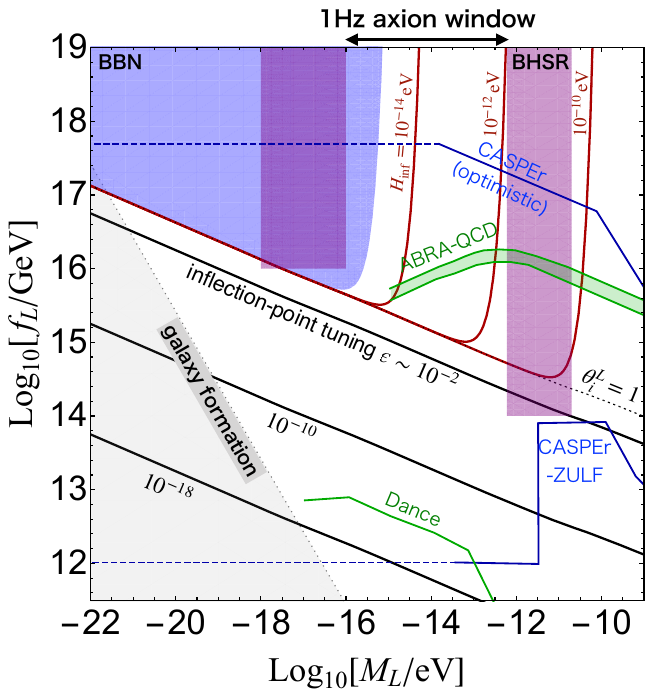
Figure 3 . The ( M L − f L ) 1 Hz axion parameter space fixing with Ω tot h 2 ≈ Ω L h 2 = 0 . 12 with TCC-satisfying ultra-low-scale inflation. Rolling of the axion fields fixes θ I = ( H inf /M pl ) M 2 I / 3 H 2 inf , i and we consider H inf = 10 − 14 , 10 − 12 , 10 − 10 eV from left to right for the red solid lines. The purple regions and blue region may be excluded by BHSR and BBN constraint, respectively. Below the dotted line, which denotes the standard realignment mechanism, we show the contours for the slope parameter at the inflection point of the effective potential for φ for the correct abundance. The gray shaded region may be excluded since the oscillation of φ happens with T . keV . The lower and upper blues lines are the sensitivity reach of the CASPEr-ZULF experiment with c φ = 1 taken n from [28], and the optimistic projection taken from ref. [27] assuming only spin noise, respectively. Dashed lines are our extrapolations. Below the upper and lower green band (line), the region can be tested in the ABRACADABRA experiment with c φ = 1 adopted from [111] and the projected γ reach of the recently-proposed DANCE experiment [30, 31],